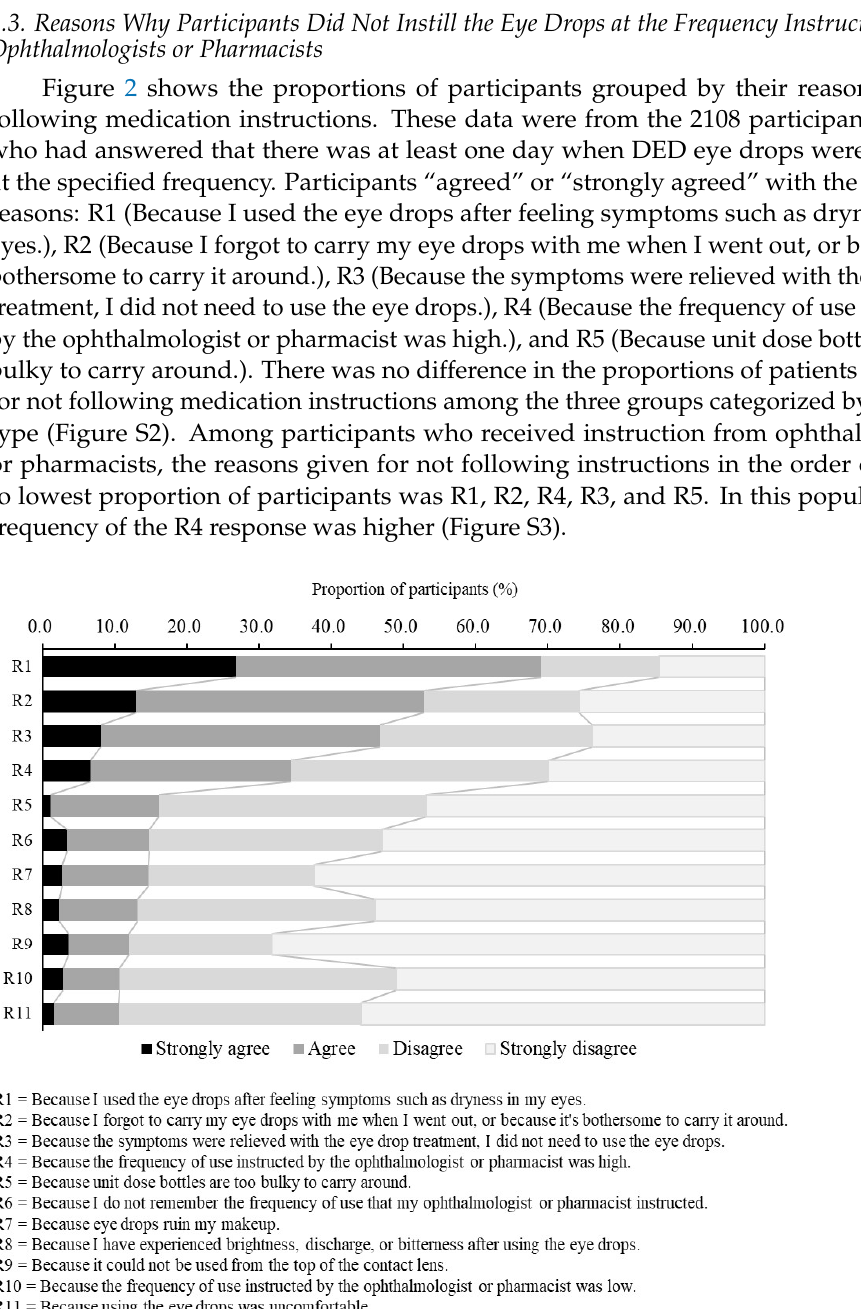
Figure 2. Reasons participants gave for not instilling the eye drops at the frequency instructed by ophthalmologists or pharmacists. The 11 reasons were evaluated on a 4 point scale (Strongly agree, Agree, Disagree, Strongly disagree). DED: dry eye disease.